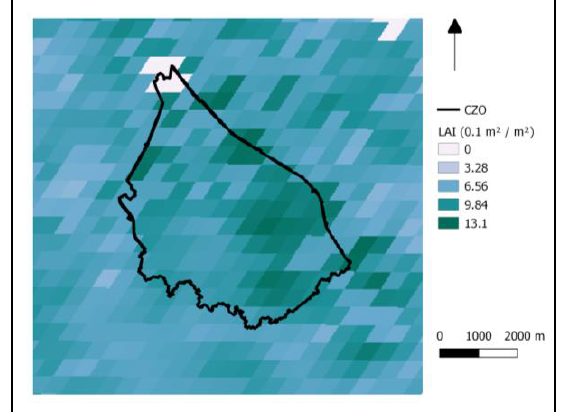
Figure 2.2. Leaf Area Index (LAI)